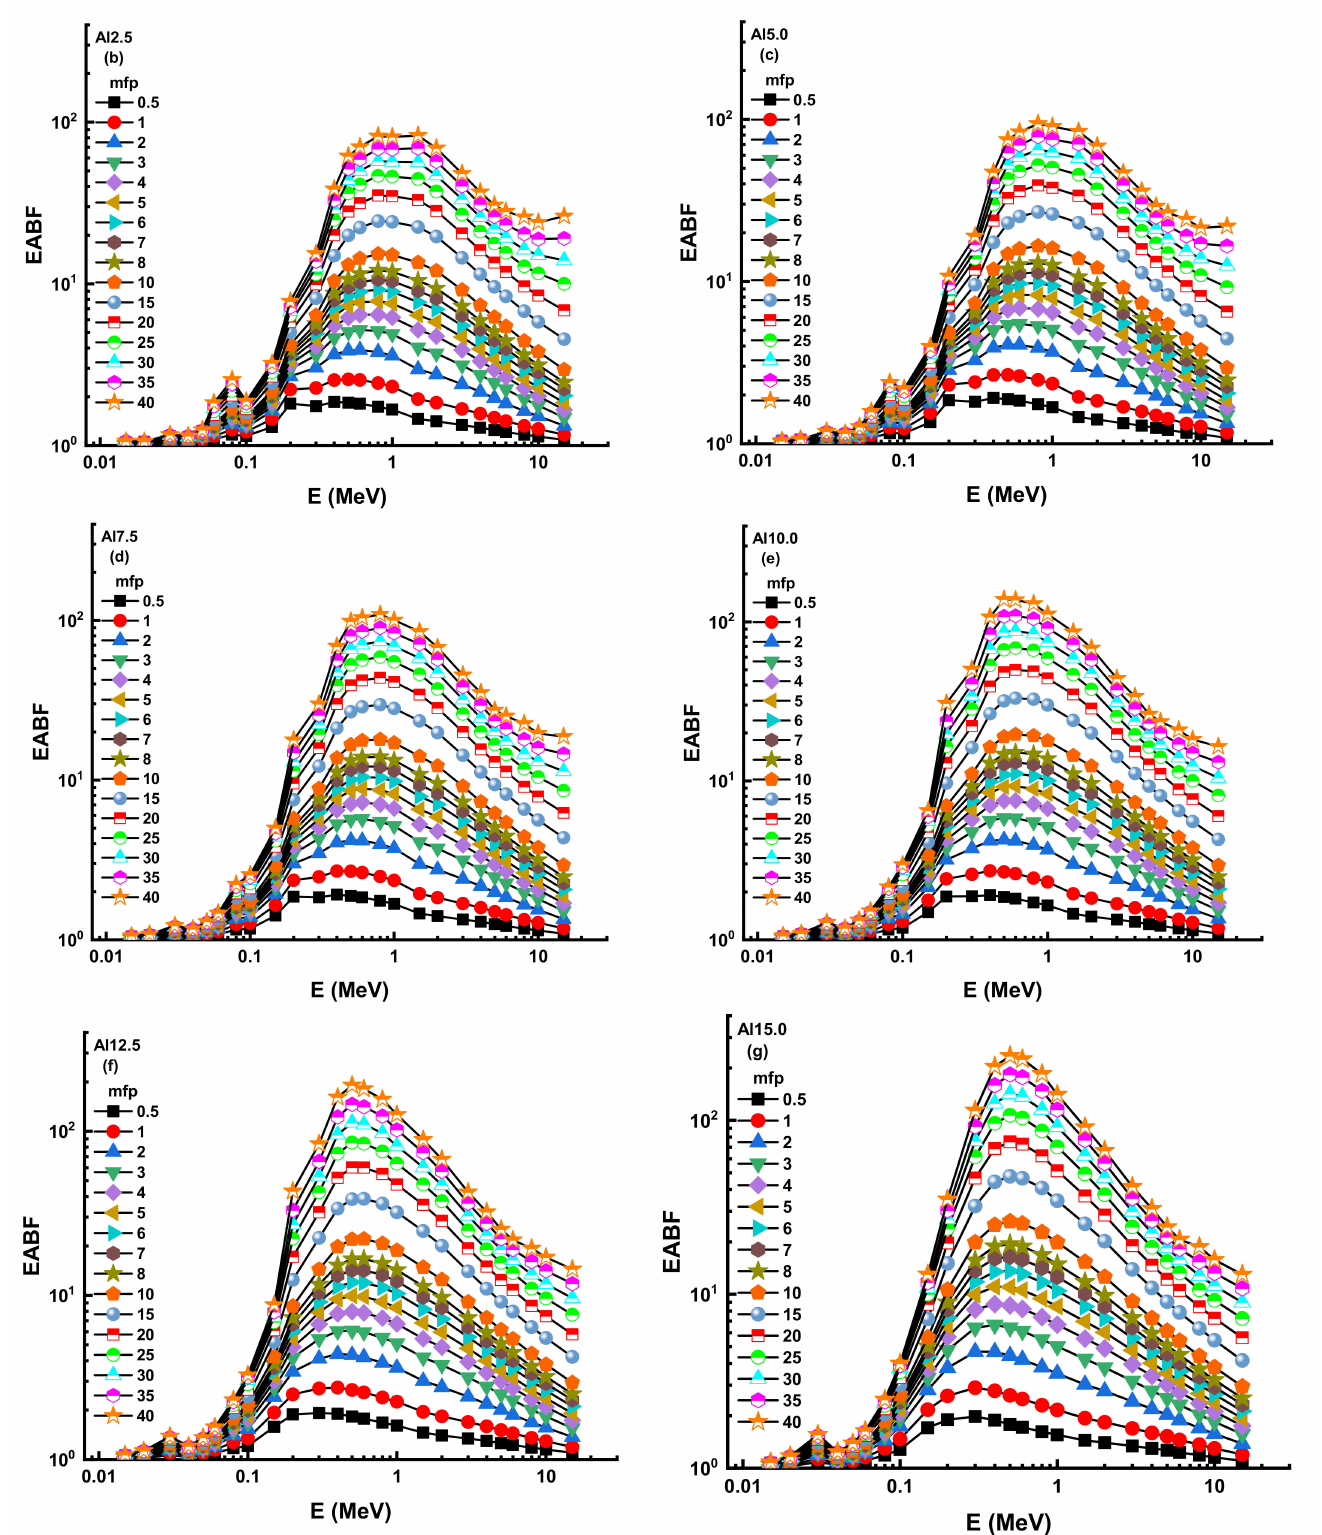
Figure 11. Variation of energy absorption buildup factor (EABF) against photon energy for all glasses. ( a ) AL0.0; ( b )AL2.5; ( c )AL5.0; ( d ) AL7.5; ( e ) AL10.0; ( f ) AL12.5; ( g )